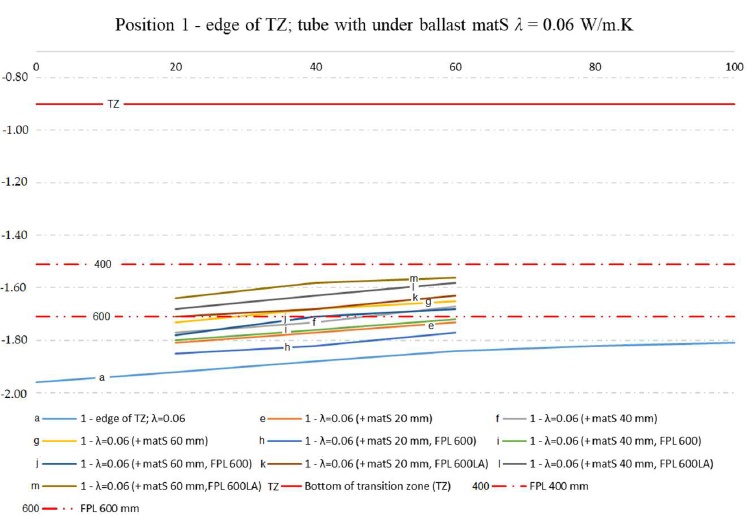
Figure 10. Frost course and used material matA : λ = 0.06 W/m·K, matA with matS 20–60 mm.